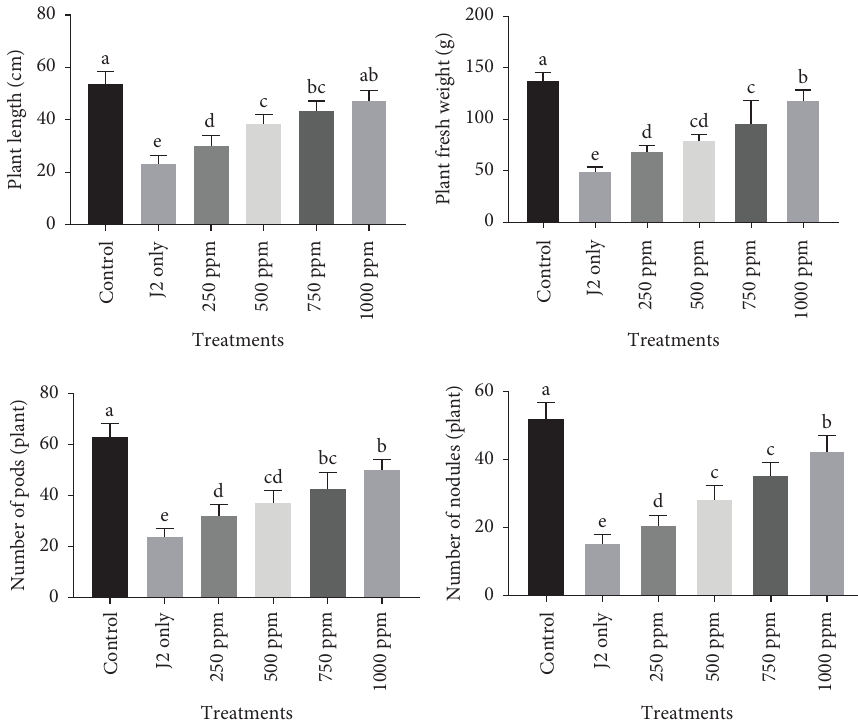
Figure 7: Efect of various concentrations (250, 500, 750, and 1000ppm) of G-ZnO NPs on the growth attributes of